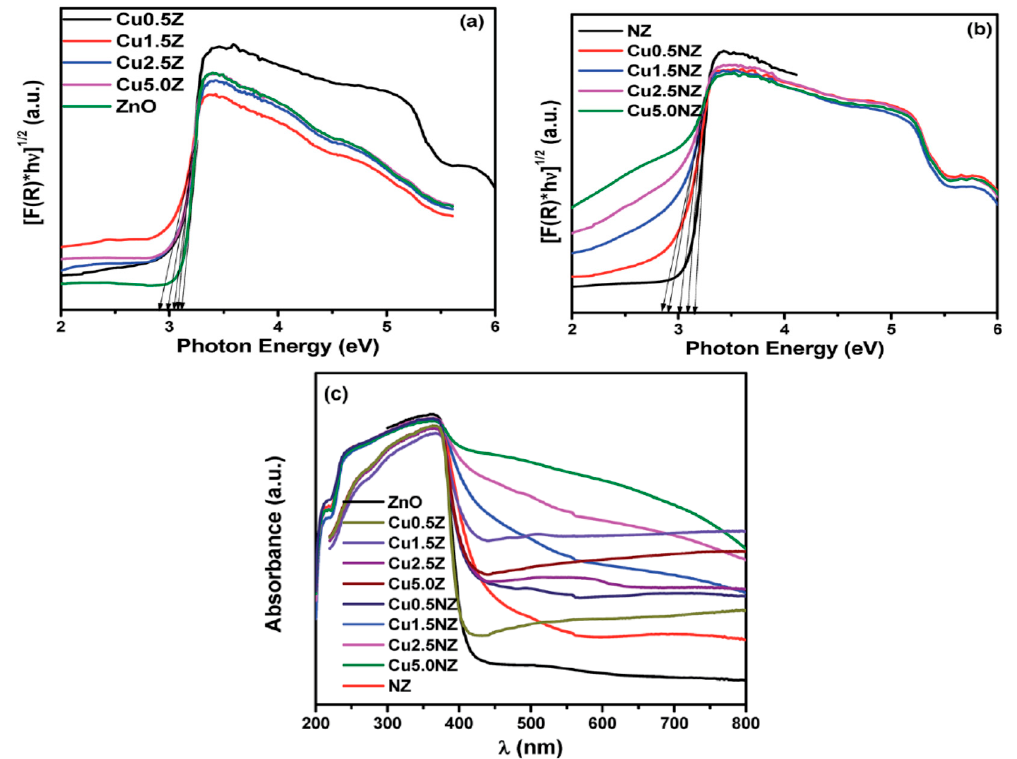
Figure 6. The plots of Kubelka–Munk function vs photon energy for evaluating bandgap energy of ( a ) ZnO and Cu0.5Z, Cu1.5Z, Cu2.5Z and Cu5.0Z, and ( b ) NZ, Cu0.5NZ, Cu1.5NZ, Cu2.5NZ and Cu5.0NZ. ( c ) Optical absorbance of ZnO, Cu0.5Z, Cu1.5Z, Cu2.5Z, Cu5.0Z, NZ, Cu0.5NZ, Cu1.5NZ, Cu2.5NZ and Cu5.0NZ. Reproduced from [135] with permission of the Royal Society of Chemistry.